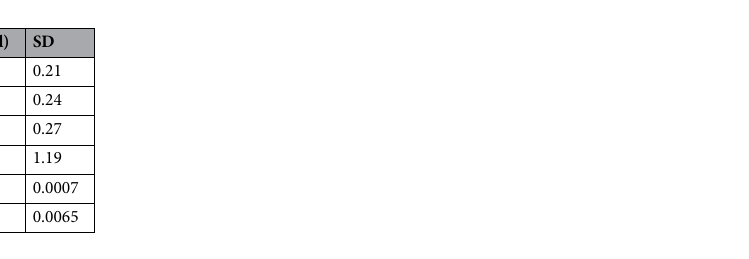
Table 2. Drug Sensitivity assay of Saudi propolis sample and its fractions on T. brucei S427 WT.